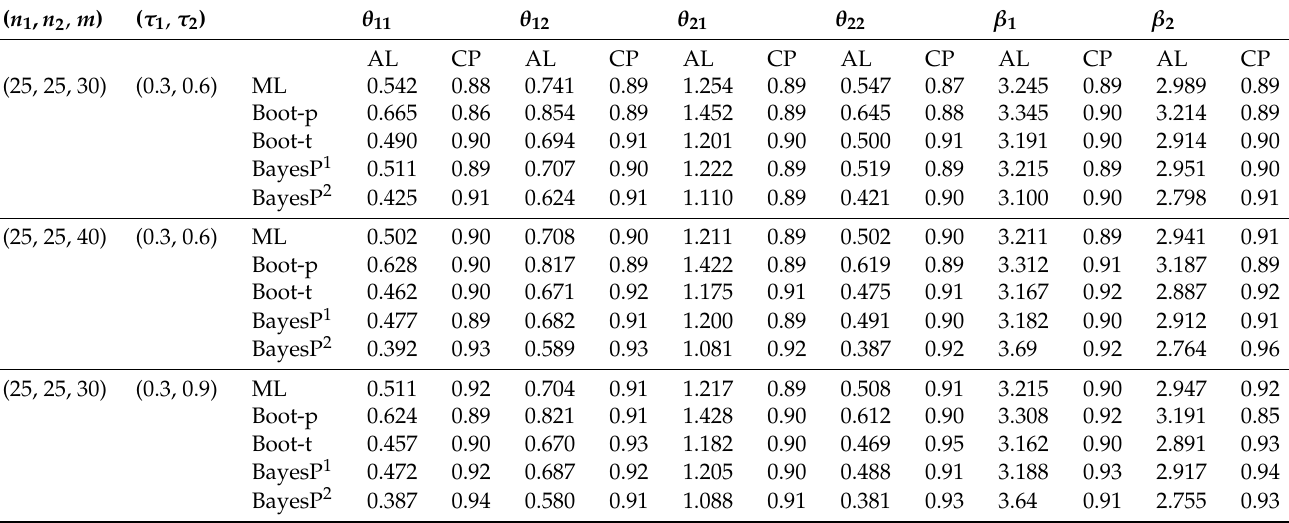
Table 4. AL and CP of the parameter estimates for Θ 2 = { 0.2, 0.3,0.4,0.2,1.0,1.0